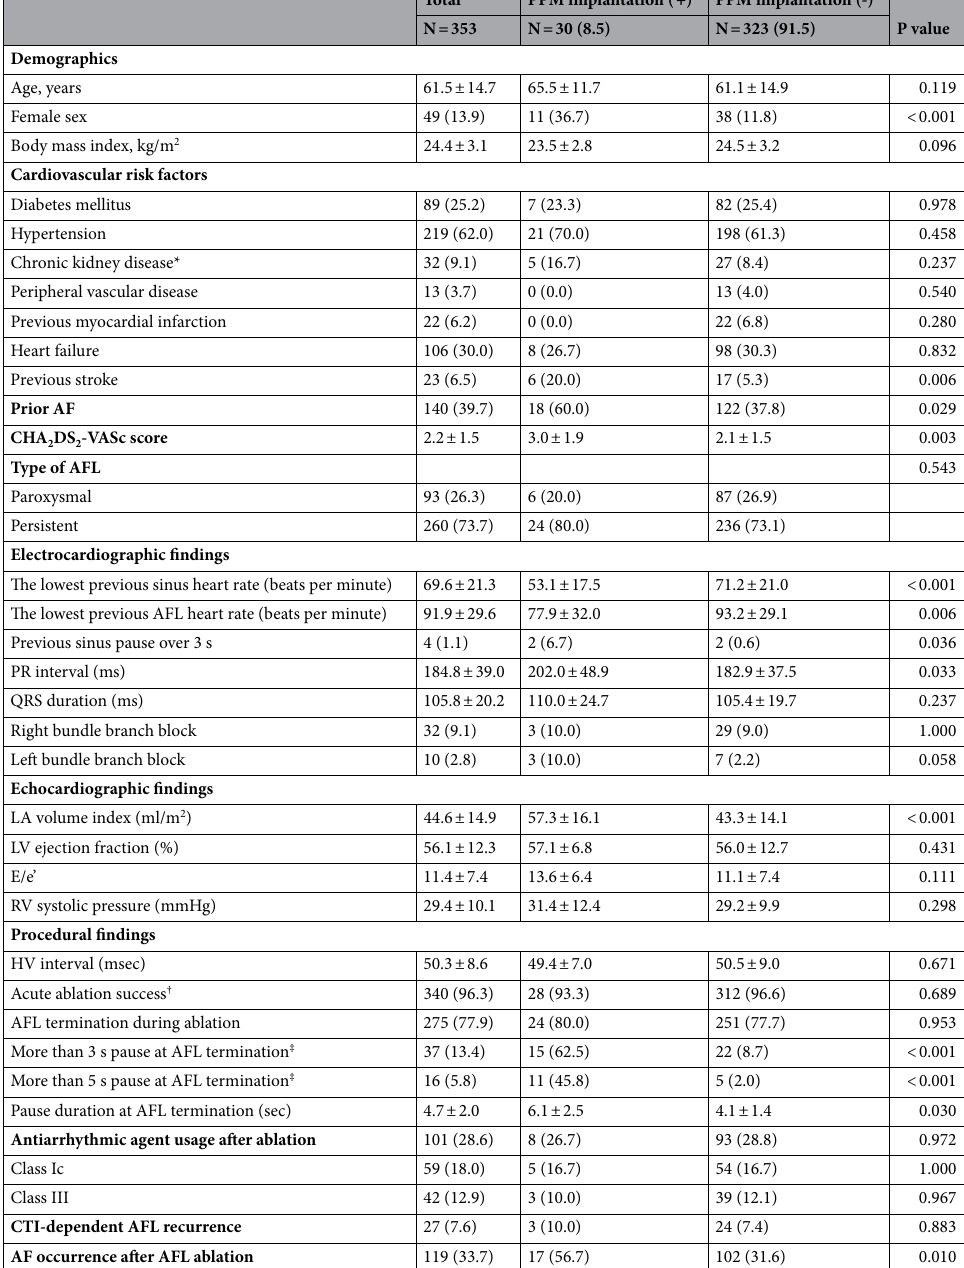
Table 1. Baseline and procedural characteristics of the study population according to PPM implantation after CTI-dependent AFL ablation. Values are presented as the mean ± standard deviations or number (%). AF atrial fibrillation, AFL atrial flutter, CTI cavotricuspid isthmus, LA left atrium, LV left ventricle, PPM permanent pacemaker, RV right ventricle. *Chronic kidney disease was defined as serum creatinine ≥ 2.0 mg/ dl. † The successful endpoint of ablation was bidirectional electrical block. ‡ The denominator was the number of patients who underwent atrial flutter termination during